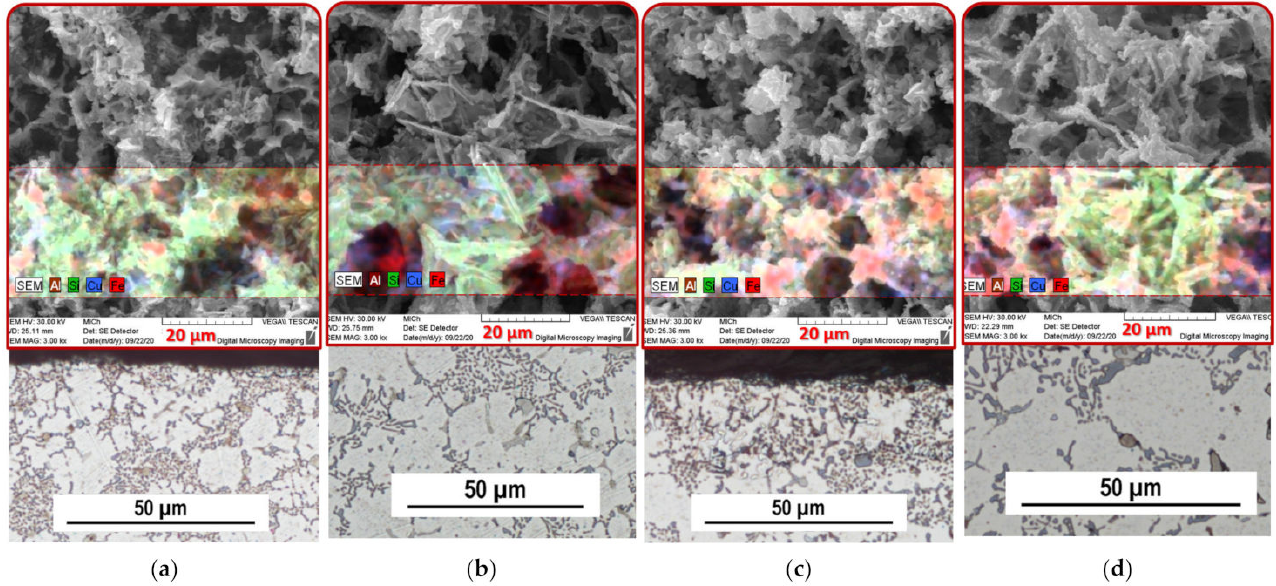
Figure 9. Images of the structure of the casting from the Z75 and Z90 alloys after heat treatment; OM, SEM: ( a ) Z75 surface; ( b ) Z75 central region; ( c ) Z90 surface; ( d ) Z90 central region.